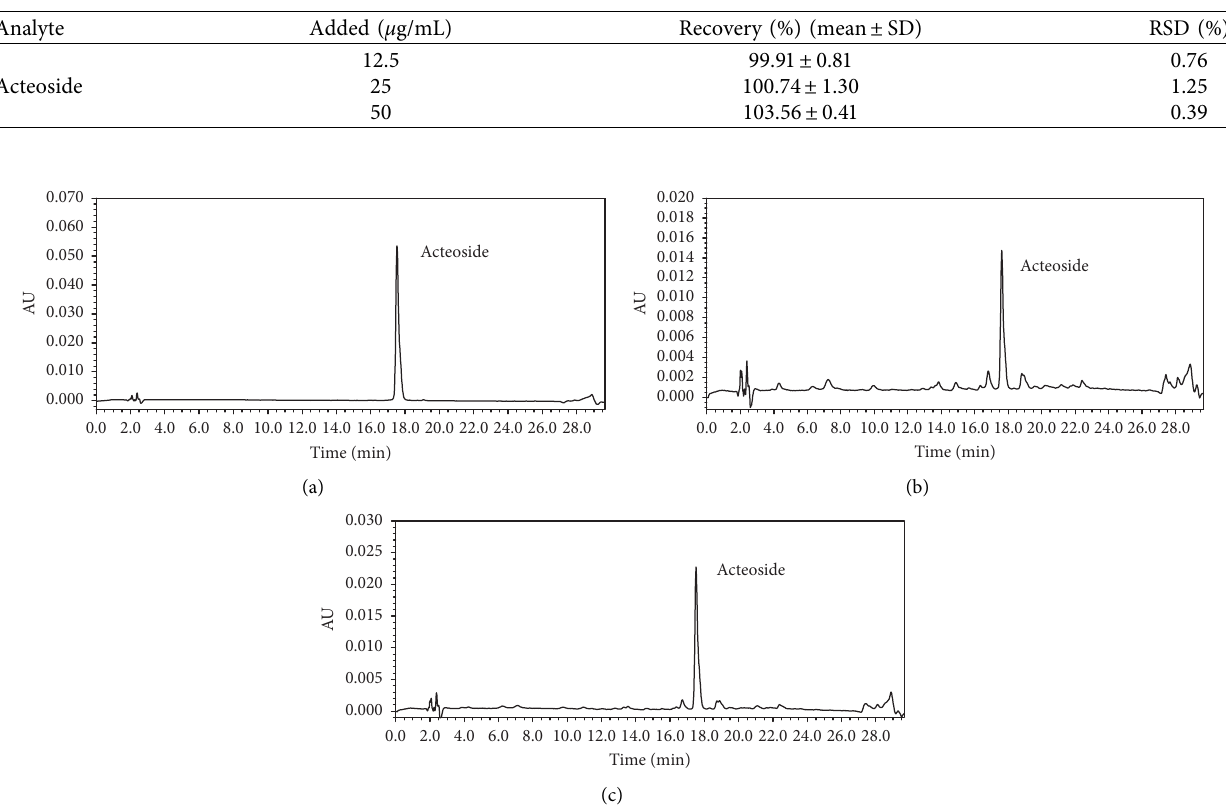
Table 5: Recovery of the present method ( n � 6).